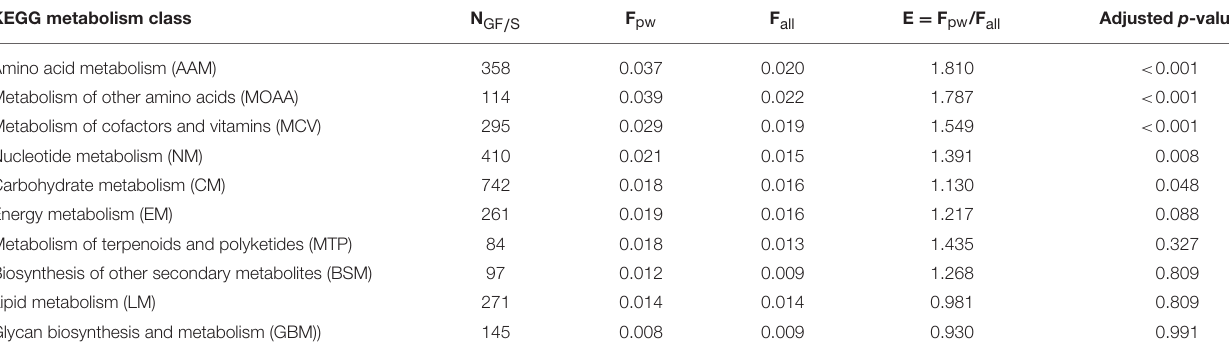
Table lists for all 10 KEGG metabolism classes (KEGG class “Overview” was not considered) the number of gene families or singleton genes (jointly referred to as gene objects, N GF / S ) annotated to them, the fraction of all profile-profile comparisons among all N GF / S gene objects yielding identical profiles within a class (F pw , Equation 1), the fraction of all profile-profile comparisons of N GF / S gene objects yielding identical profiles within and to gene objects outside a class (F all , Equation 2), the resulting fold enrichment (E = F pw /F all ) of identical phylogenetic profiles within a class relative to expectation, and 30 associated Benjamini-Hochberg corrected empirical p-value based on 10,000 random class assignments. Results are based on Network30-based gene family assignments (see Methods). Metabolism classes are sorted in ascending order of p-value. Highlighted bold are the secondary metabolism